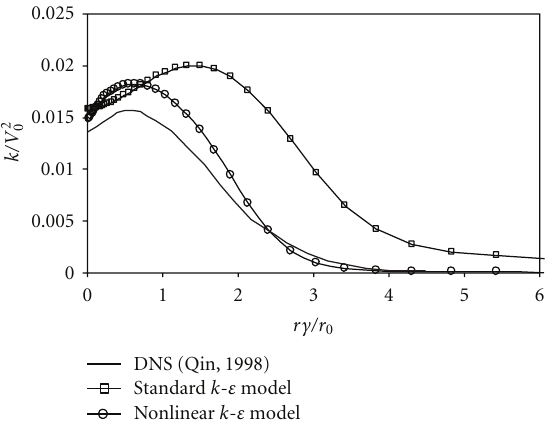
Figure 10: Radial distribution of depth calculated by RANS and LES (symbols indicates LES prediction, and lines show the corresponding RANS prediction).